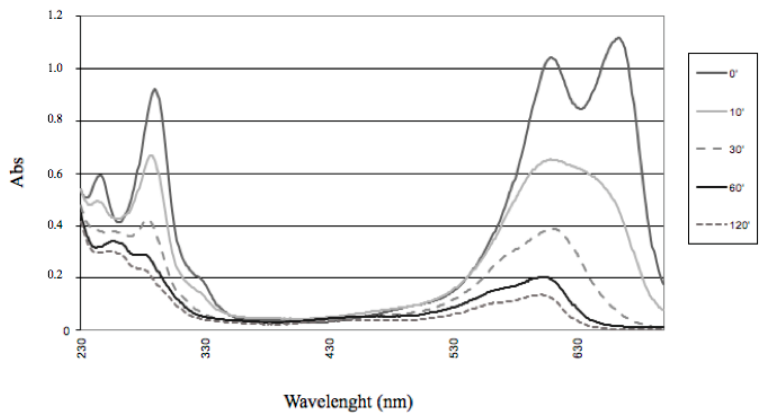
Figure 9. Spectral changes during MB oxidation by FSG-Pyr/FeTPFPP in the presence of hydrogen peroxide.